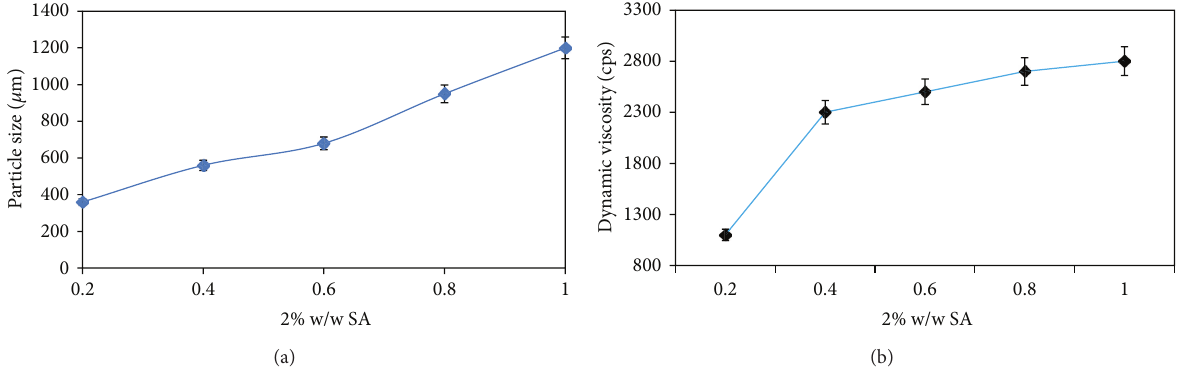
Figure 6: Effect of SA on (a) particle size and (b) dynamic viscosity of SA/CMC blend crosslinked with Ca 2+